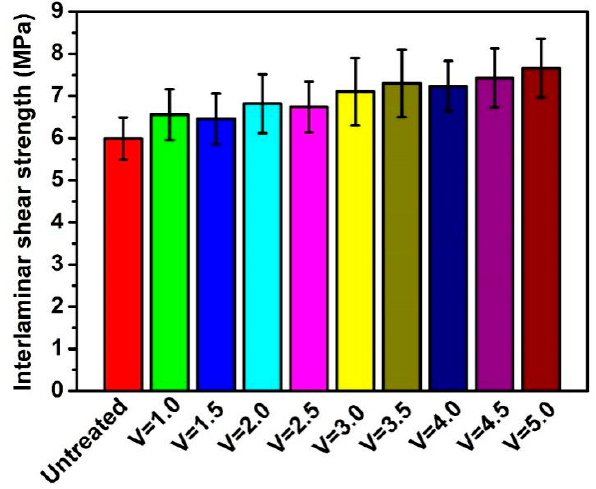
Figure 5. Interlaminar shear strength of composite before and after coating.